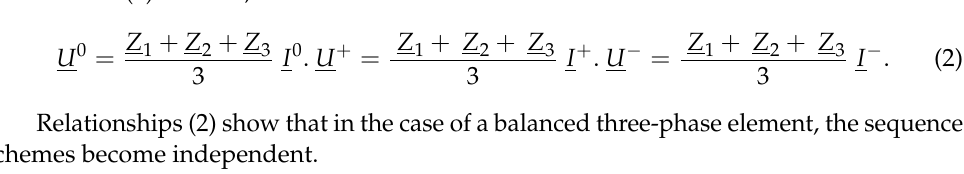
Figure 2. Unbalanced three-phase element.